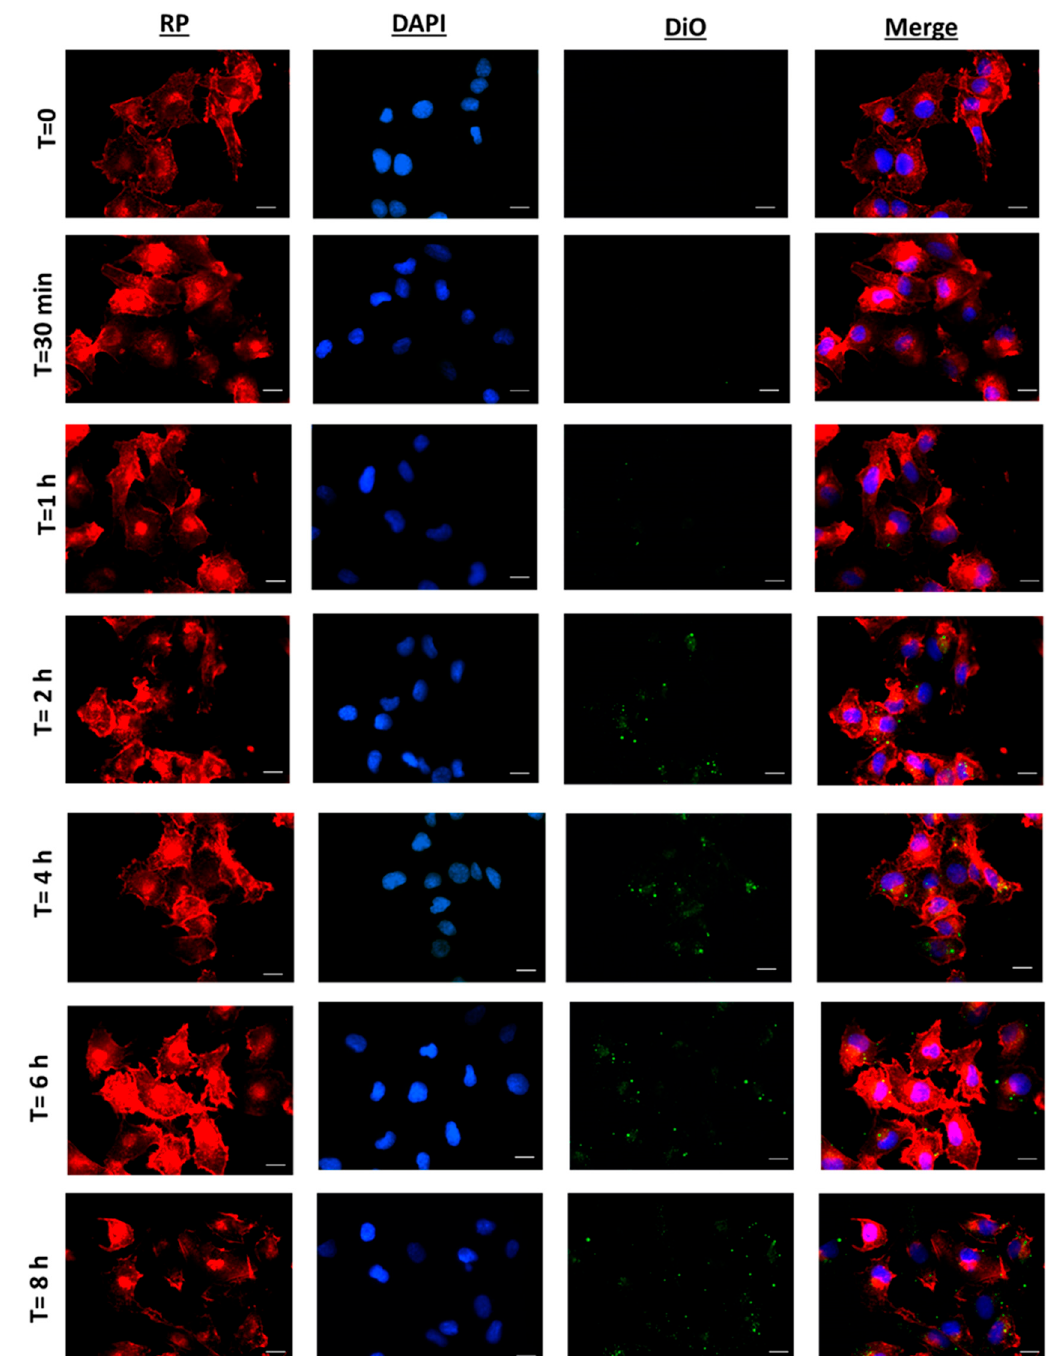
Figure 4. Fluorescence microscopy of SKOV-3 cells incubated with DiO-NPs (at a concentration of 1mg/mL) for 30 min to 8 h. Red images indicate cell cytoskeleton staining (red phalloidin, RP). Blue images indicate nucleus staining (DAPI). Green colour shows DiO-NPs. Uptake experiments were performed in triplicate ( n = 3). Scale bar: 20 µm.